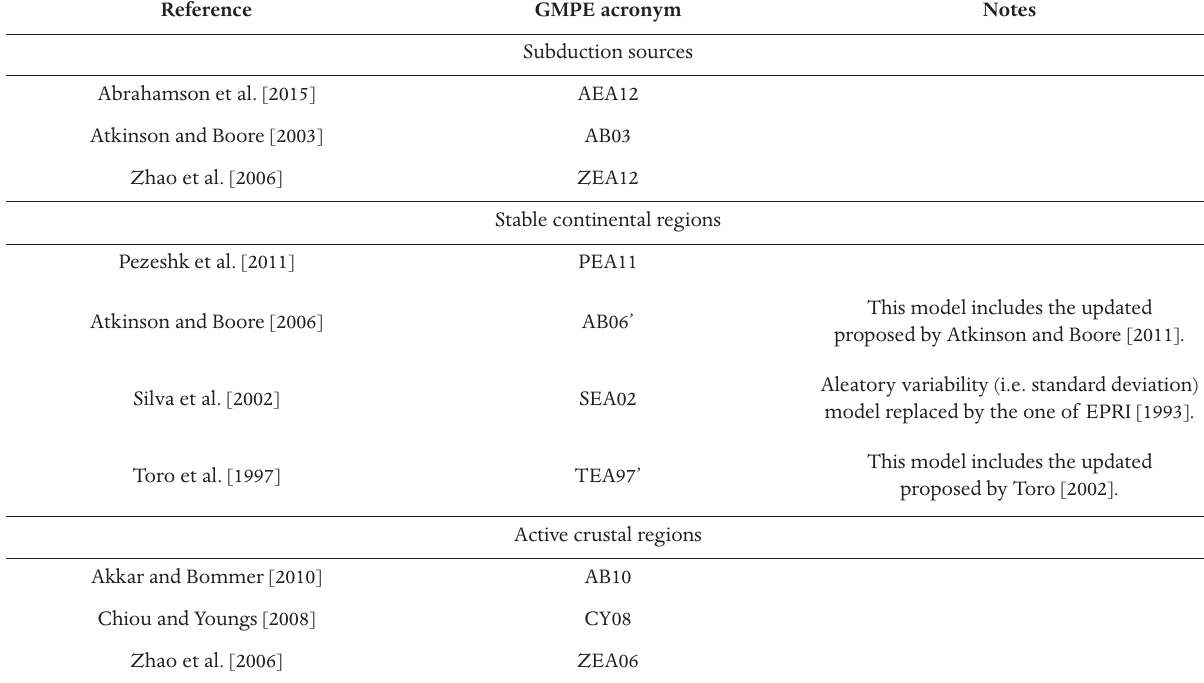
Table 1. Ground motion prediction equations selected by the Global GMPEs project for the calculation of seismic hazard at a global